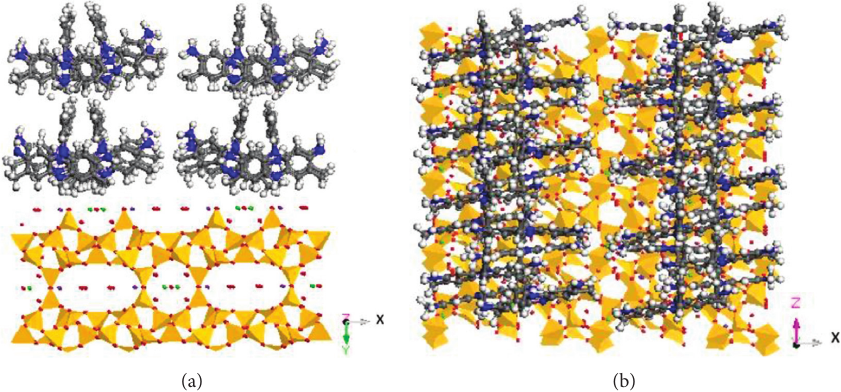
Figure 10: Molecular dynamic simulation showing SO uptake on the {010} surface (a) and projection along [010] (b) of ZEO. Supercell is made of 2 ax 4 c